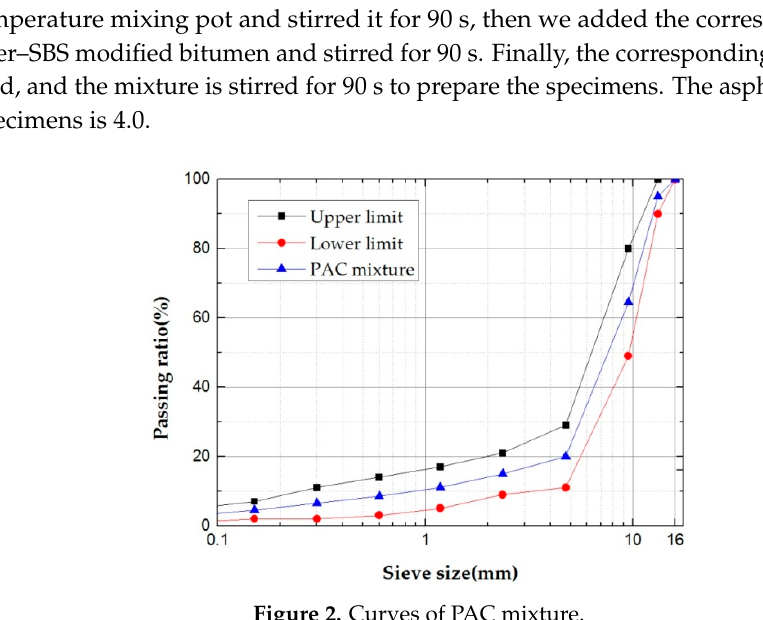
Figure 2. Curves of PAC mixture.